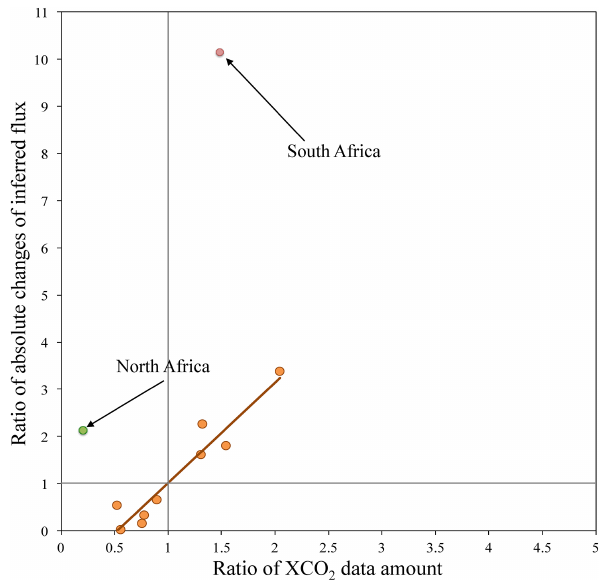
Figure 7. Scatter plot for the ratio of GOSAT to OCO-2 XCO 2 data amount versus the ratio of absolute changes in the land sinks caused by GOSAT to OCO-2 in the 11 TRANSCOM land